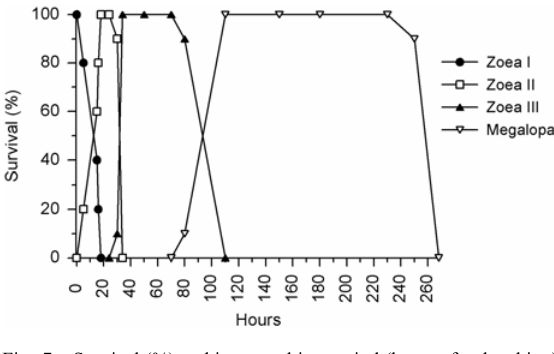
Fig. 7 – Survival (%) and intermoulting period (hours after hatching) of Lepidophthalmussiriboia larvaerearedinthelaboratoryandsubmit- ted to an initial starvation period. In this treatment, they were starved during 1 day.